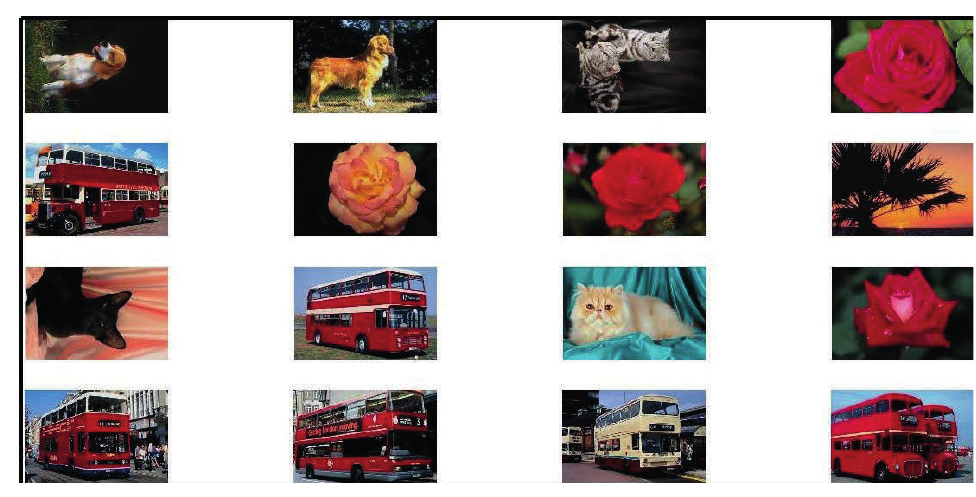
Fig. 19. Bus images retrieved using K-Means based CBIR.